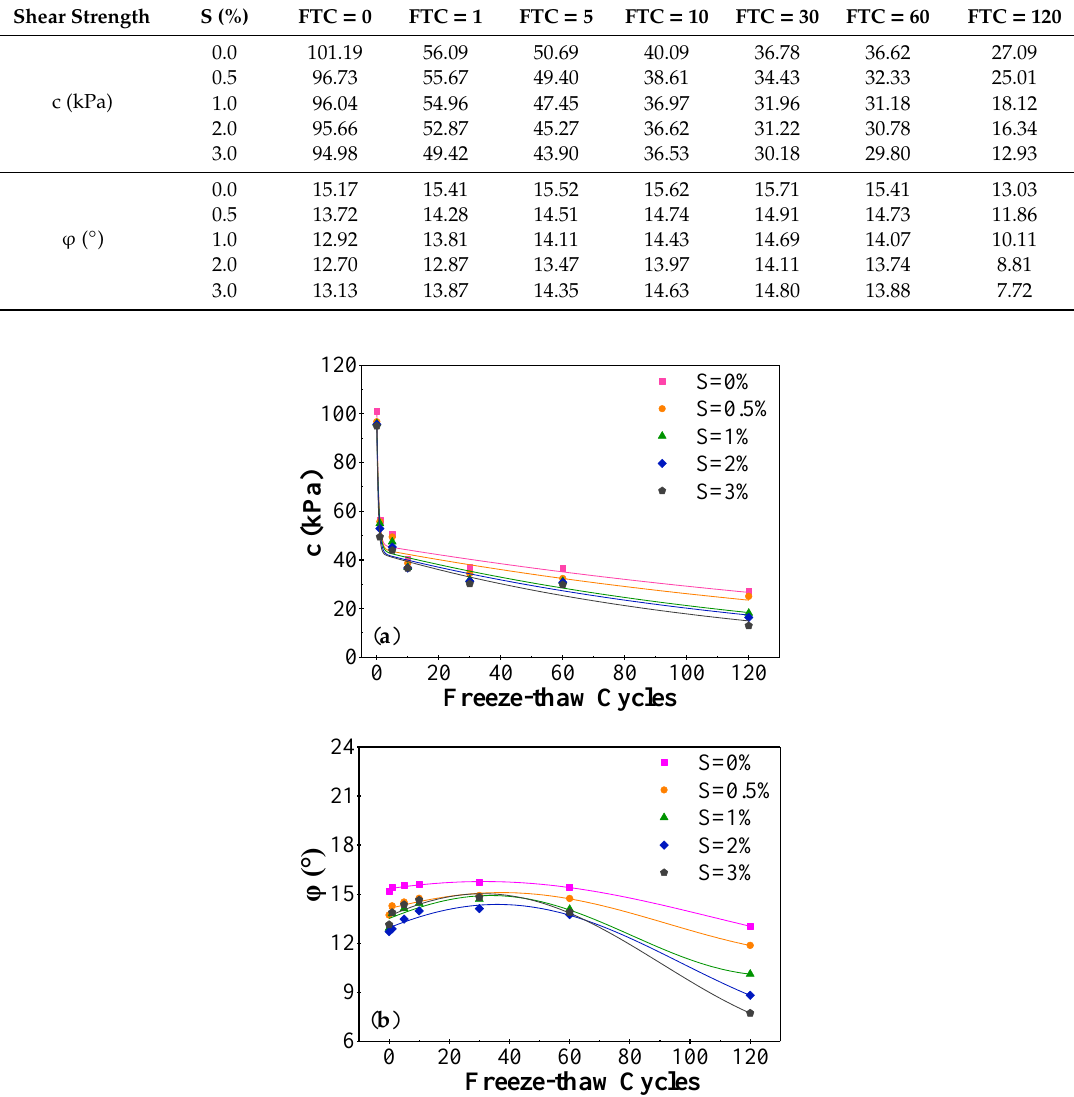
Table 4. Sample cohesion c and friction angle φ. Shear Strength